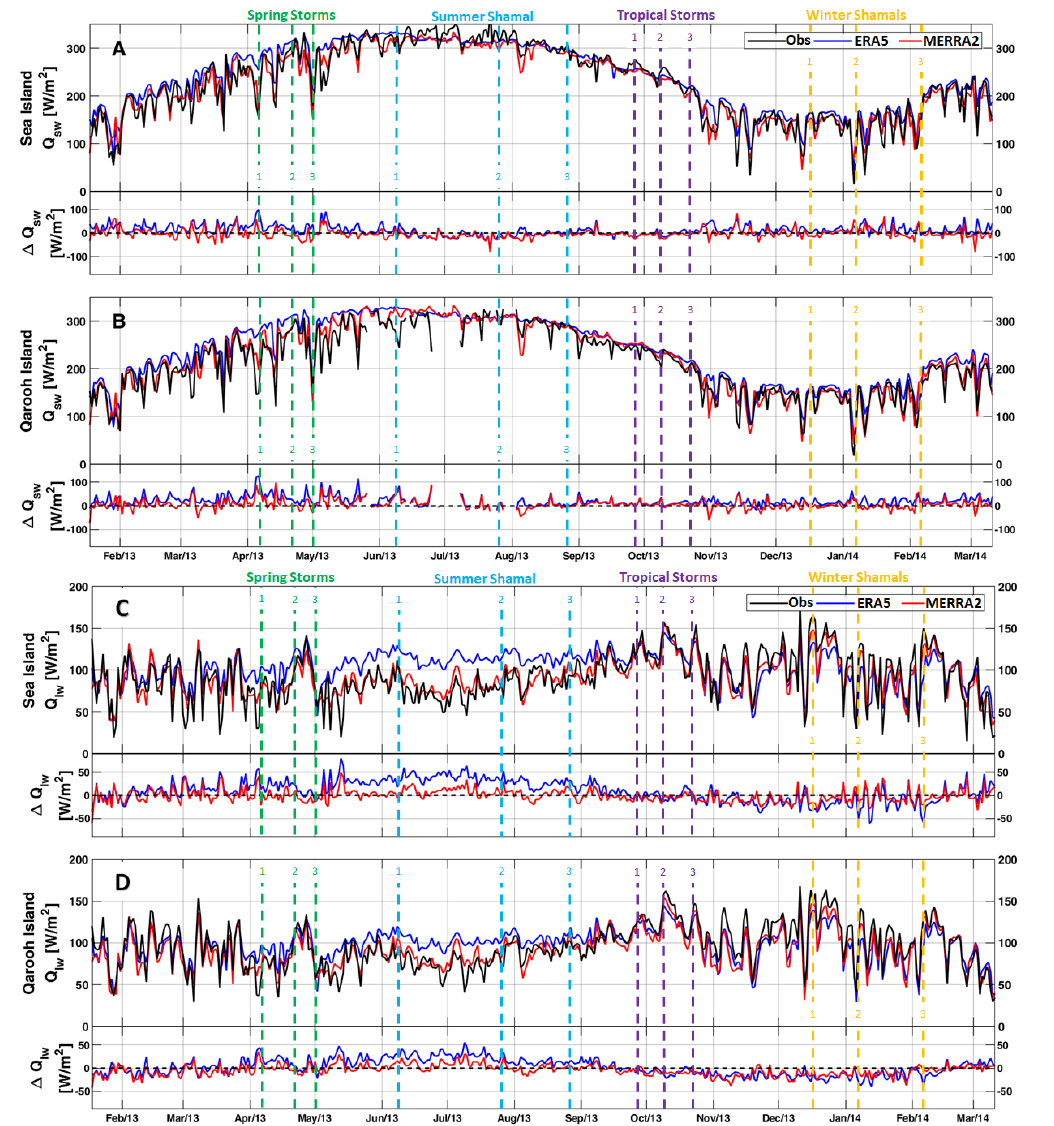
Figure 3. Daily average shortwave ( A , B ) and longwave ( C , D ) radiation heat fluxes derived from reanalysis products (ECMWF-ERA5 blue and NASA-MERRA2 red) and observations (black). Differences can be seen at the Sea Island and Qarooh Island stations. Positive differences indicate overestimates, and vertical dashed lines indicate spring wind events (green), summer Shamals (blue), tropical storms (magenta), and winter Shamals (orange). ∆ Q sw ( A ) and ∆ Q lw ( B ) represent the difference between reanalysis products and